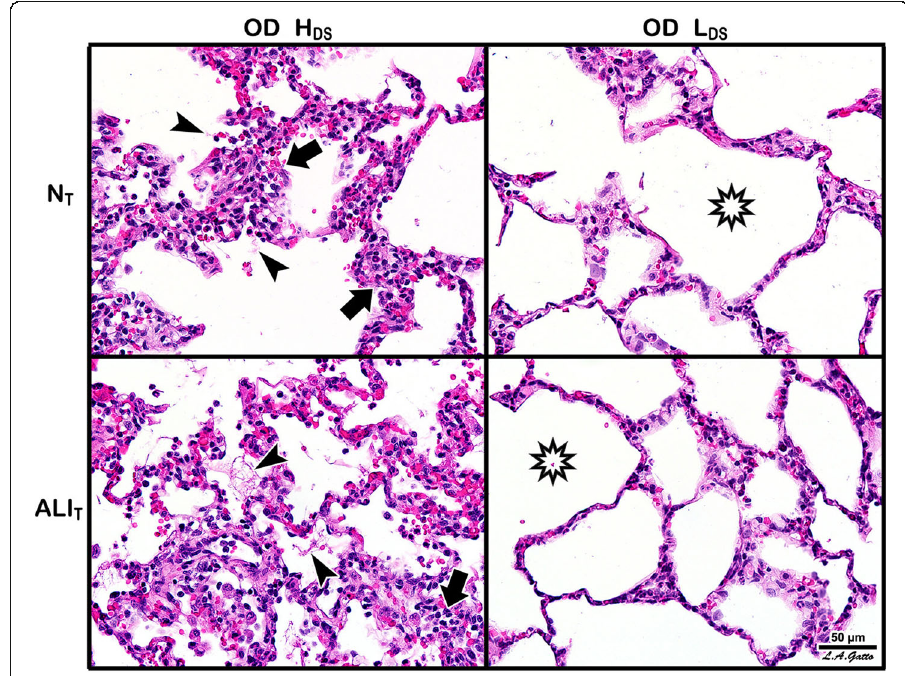
Fig. 7 Histopathology following ventilation with high ( OD + H DS ) and low ( OD + L DS ) dynamic strain and in normal ( N T ) and acutely injured ( ALI T ) lung tissue. Arrows indicate cell infiltration, while arrowheads indicate the presence of fibrin deposits in the air compartment; both had higher incidence with H DS irrespective of injury. Stars highlight alveolar patency, which was greater with L